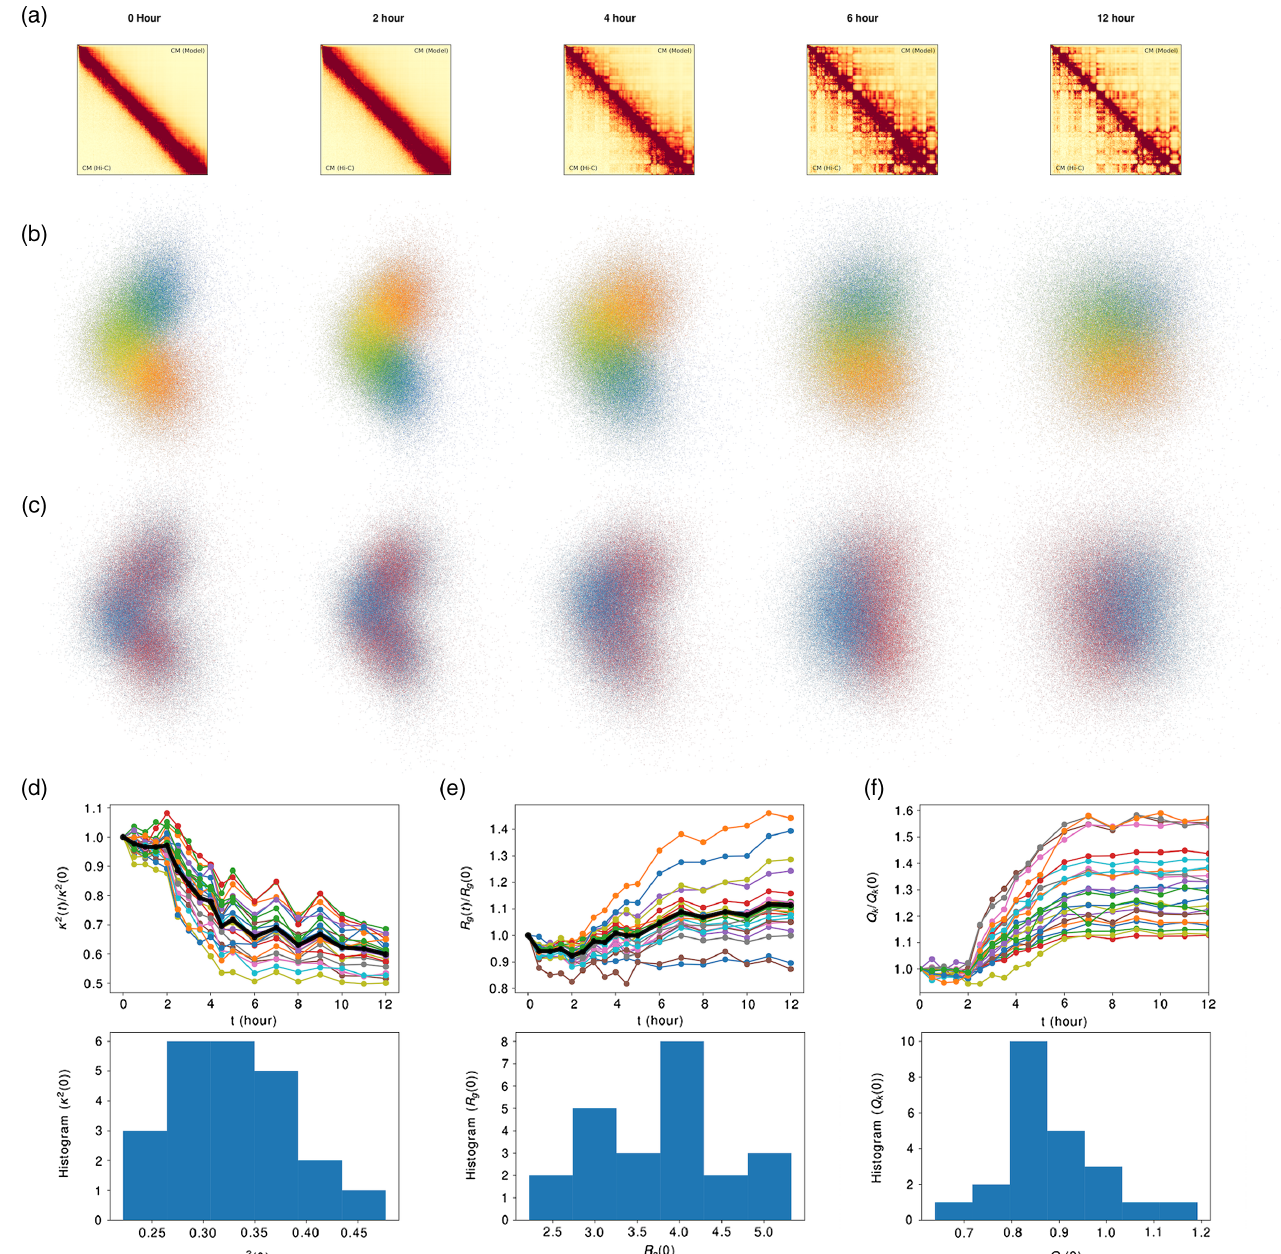
FIG. 8. (a) Comparison between Hi-C CM and the simulated CM using the HIPPS method for HeLa cell line chromosome 14 at 0, 2, 4, 6, 12 h after the release from prometaphase. The experiment Hi-C data are taken from Gene Expression Omnibus (GEO) repository under accession number GSE133462. The simulated CM is calculated from an ensemble of 10 000 3D conformations with a chosen contact threshold whose value is determined to minimize the squared difference between the Hi-C and simulated CM. (b) Superposition of 1000 3D structures for chromosome 14 at each time point. Each point represents one locus from one conformation. The color encodes the genomic location of the loci along the genome. (c) Same cloud representation as (b) with colors indicating the A and B compartments. (d) Top: the change of κ 2 as a function of time. κ 2 is normalized by its initial ( t ¼ 0 ) value κ 2 ð 0 Þ . Bottom: the histogram 0 Þ . Bottom: the as a function of time. R is normalized by its initial value R of κ 2 ð 0 Þ . (e) Top: the change of the radius gyration R g g g ð 0 Þ . (f) Top: the time evolution of the degree of compartmentalization Q , which is calculated using Eq. (9). Bottom: the histogram of R g ð k 0 Þ . (d,e,f) Top: each colored line represent one of the 23 histogram of Q k ð